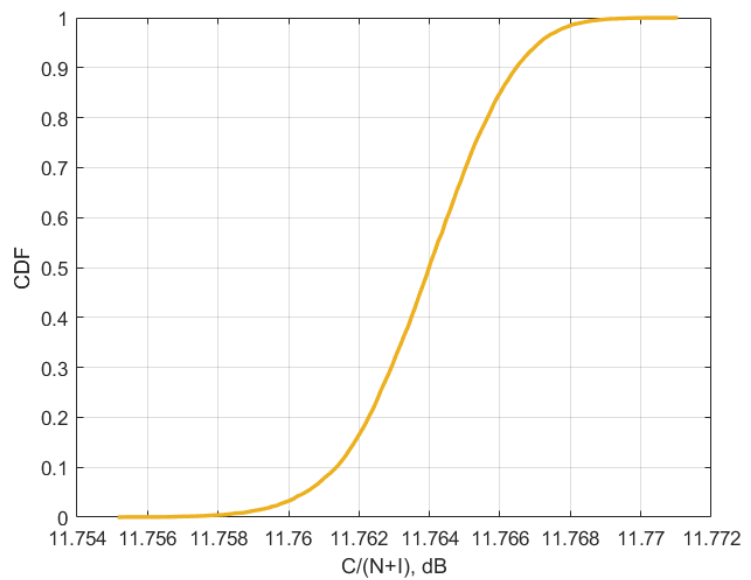
Sensors 2023 , 23 , x FOR PEER REVIEW 13 of 19 Figure 12. Cumulative distribution function of C/(N+I) for Yamal 90E for 6/4 GHz. Figure 12. Cumulative distribution function of C/(N + I) for Yamal 90E for 6/4 GHz.